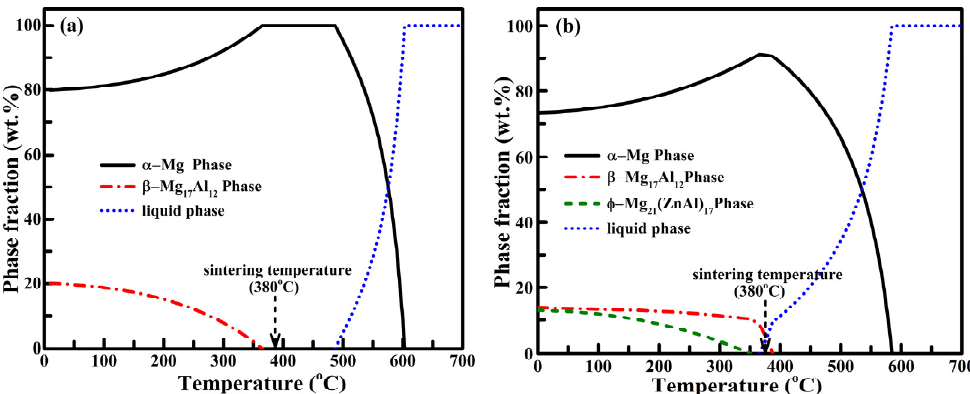
Figure 2. Simulation results of phases changing with temperature in Mg-Al-Zn alloys: ( a ) Mg-9Al-1Zn alloy; ( b ) Mg-9Al-5Zn alloy.